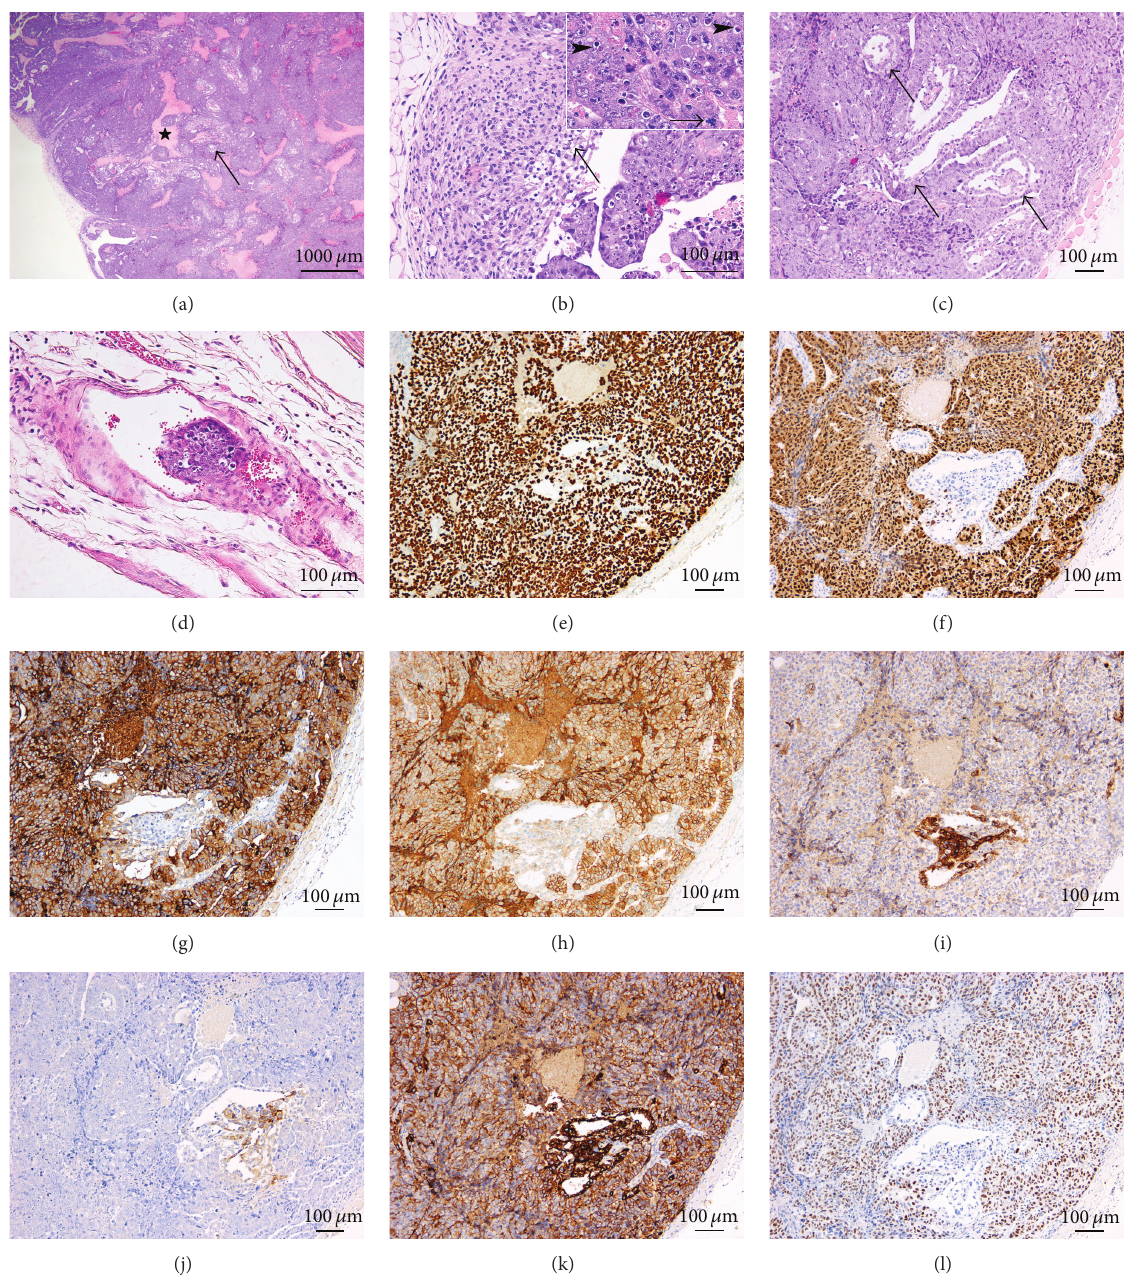
Figure 4: iPSC generated from human hepatocytes, using the OKSM integrative vector. The generated tumors were mostly solid, with an intimately admixed minor component of irregular gland-like spaces ( arrow ); tumor cells formed serpiginous ribbons around central foci of tumor necrosis ( star ) (a, H&E 20x). Rarely, minute foci of immature mesenchymal cells were seen ( arrow ) (b). The major component was composed of pleomorphic malignant-appearing embryonal carcinoma cells that were large and primitive-appearing, with vesicular nuclei and prominent nucleoli; mitoses ( arrow ) and apoptotic bodies ( arrowheads ) were numerous (b, inset, H&E 400x). Gland-like spaces lined by immature cells were focally seen and corresponded to a minor yolk sac tumor component ( arrows ) (c, H&E 100x). Intravascular tumor embolism from the embryonal carcinoma component, a further malignancy criterion, was seen (d, H&E 200x). In the embryonal carcinoma component, strong and diffuse nuclear expression of SALL4 (e, 200x) and OCT4 (f, 200x) was seen, as well as moderate-to-strong membranous and cytoplasmic PLAP (g, 200x), and CD30 (h, 200x) reactivity. Contrariwise, the yolk sac component showed strong GPC3 (i, 200x) and AFP (j, 200x) reactivity. Pooled cytokeratins were expressed in both components but strongly in the yolk sac glandular structures compared to in the embryonal carcinoma component (k, 200x). MYC nuclear reactivity was seen exclusively in the embryonal carcinoma cells (l,